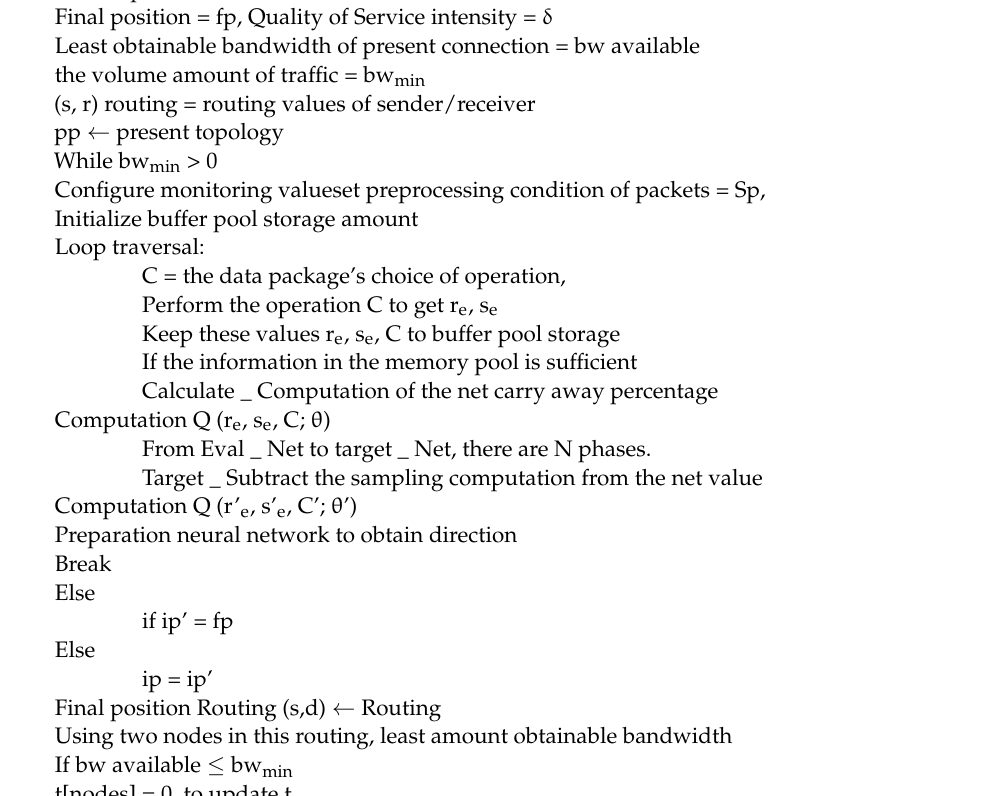
Algorithm 1 Multi-Cooperative Communication Channel Path